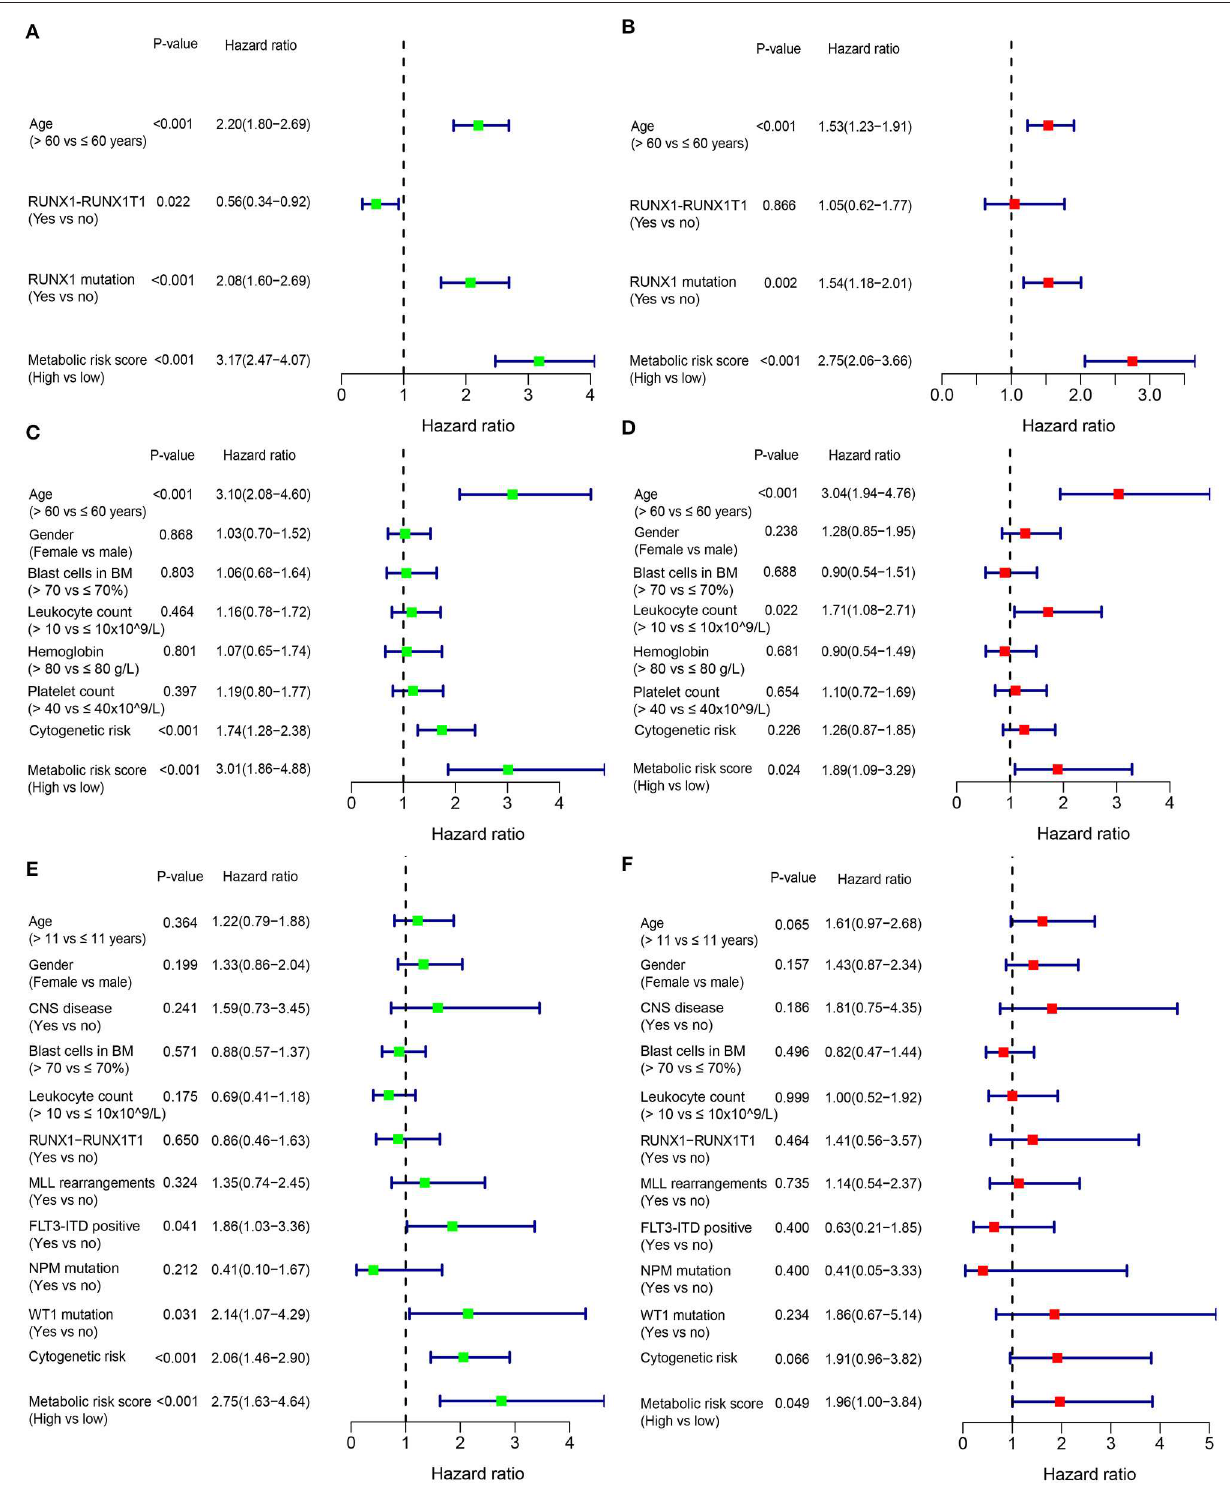
Frontiers in Oncology | www.frontiersin.org